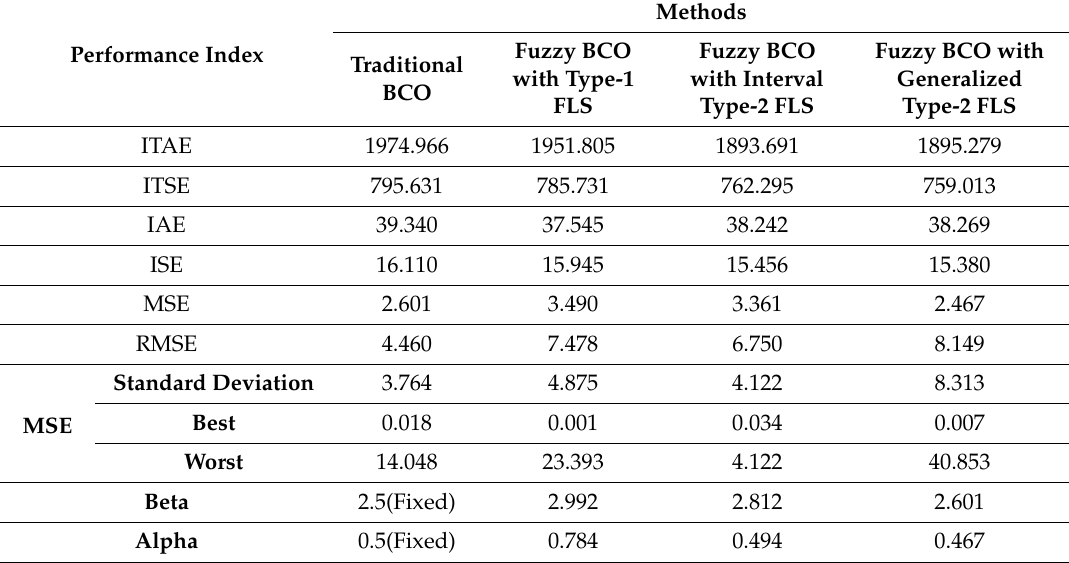
Table 7. Simulation results with pulse generator perturbation in the